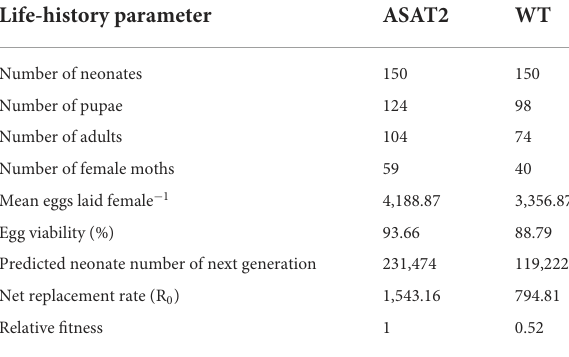
TABLE 1 Life tables and relative fitness of two tested populations of Spodoptera litura